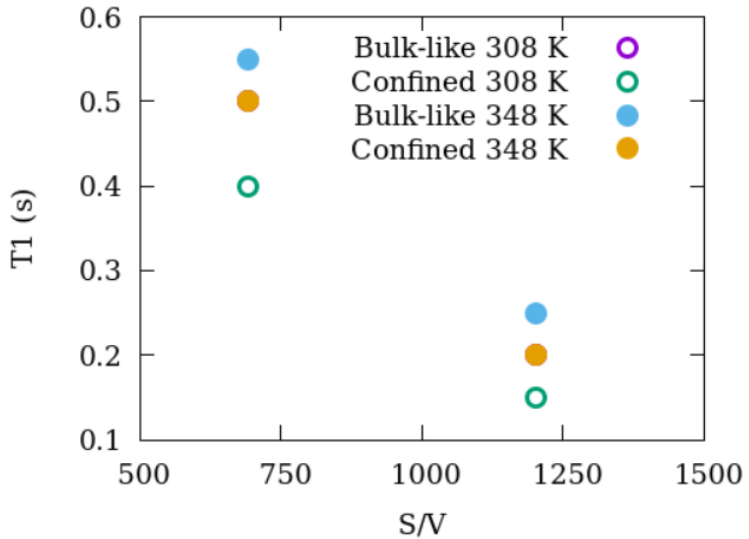
Figure 8. Change in the relaxation values of methane in mixtures with engineered nanoporous silica proxies. The open circles represent bulk-like methane, while the filled circles represent confined methane. 307 K for P = 28.2 and 112.7; 346 K for P = 32.6 and 130.3 bar.